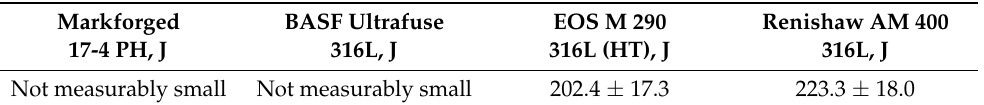
Table 9. Average and standard deviation (mean ± standard deviation) of measured impact energy. Markforged 17-4 PH, J Not measurably